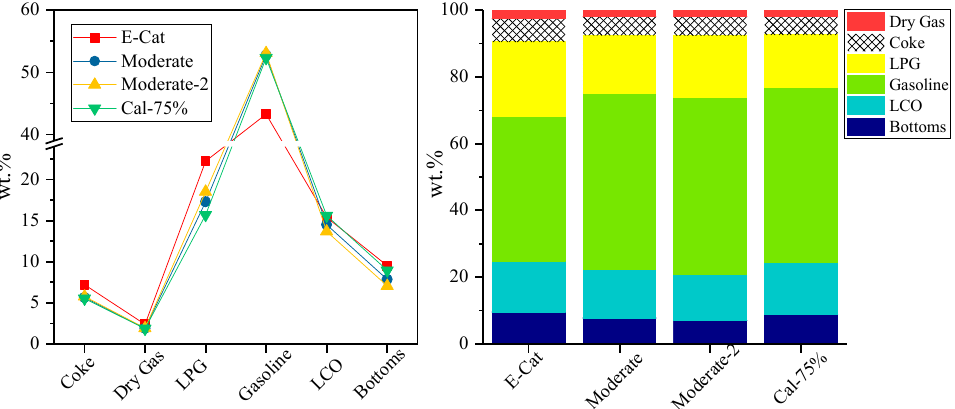
Figure 2. Comparation of yields for E-Cat and prediction: Cal-75% represents the calculated yields based on the different ratio of catalyst to oil at the conversion of E-Cat.